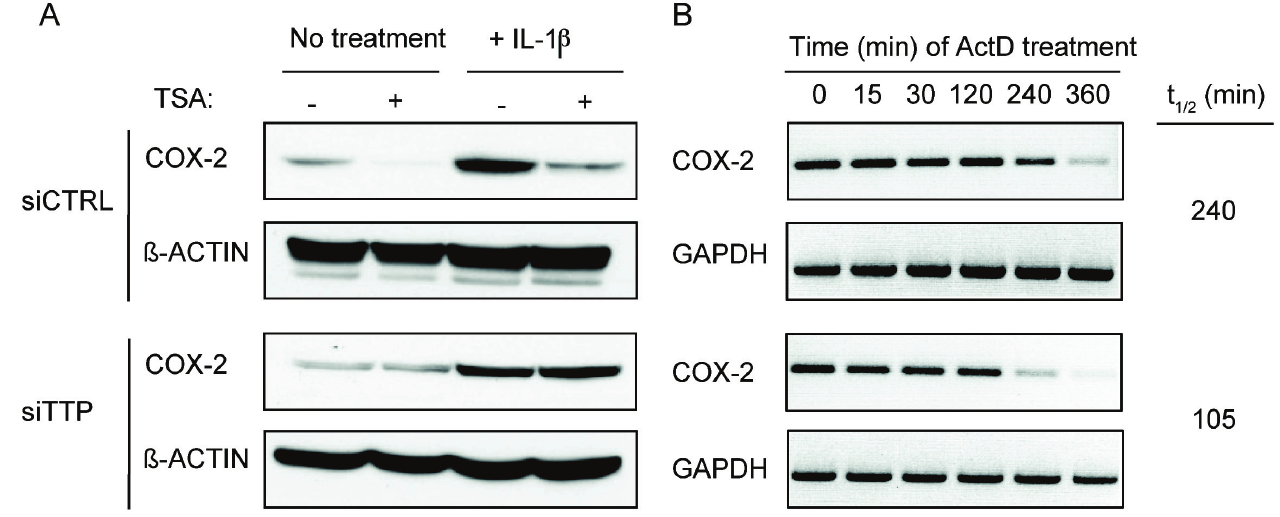
Figure 3. TSA-induced expression of TTP promotes ARE-mRNA decay. ( A ) HeLa cells were treated left untreated or stimulated with 10 ng/mL of IL-1(cid:4) for 24 h to induce COX-2 expression. Cells were then transfected with control or TTP siRNA for 36 h and then treated with TSA (0.4 (cid:3)M) for 12 h. COX-2 and (cid:4)-actin were analyzed by Western blot. ( B ) HeLa cells were stimulated with IL-1(cid:4) (10 ng/mL) for 24 h and then treated with 0.4 (cid:3)M TSA for 12 h. Act D (5 (cid:3)g/mL) was added for the indicated time points, after which COX-2 mRNA stability was assayed by RT-PCR using GAPDH as a loading control. Blots shown are representative of duplicate